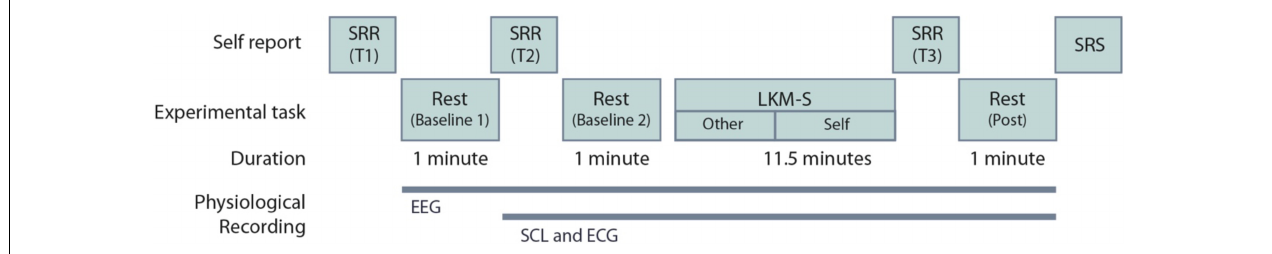
FIGURE 1 | Experimental procedure for the Loving-Kindness Meditation for the self (LKM-S). The timing of the electroencephalogram (EEG), skin conductance level (SCL), and electrocardiogram (ECG) recordings are shown. SRR are self-reported visual analog scales repeated at three time points T1-3; SRS are the self-reported measures that are collected at a single time point only, these include the PCL-C, SCS-SF, DASS and FSCSR; see Section “Self-Report Measures”.